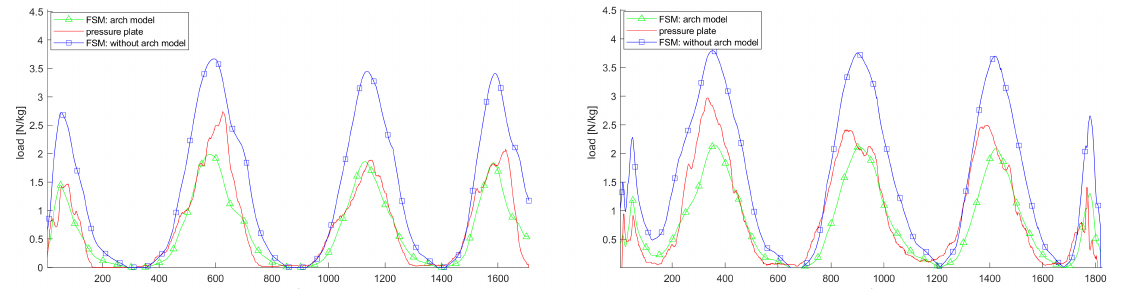
Figure 4. vGRF trajectories for the left and right foot applying isometric Gaussian functions, i.e., a s , b s = 1, for all s ∈ S , (blue squares) and optimized, elliptic functions (green triangles) during AR movement compared to the pressure plate (red line); both plots show the estimations and measurements in Newton per kilogram.